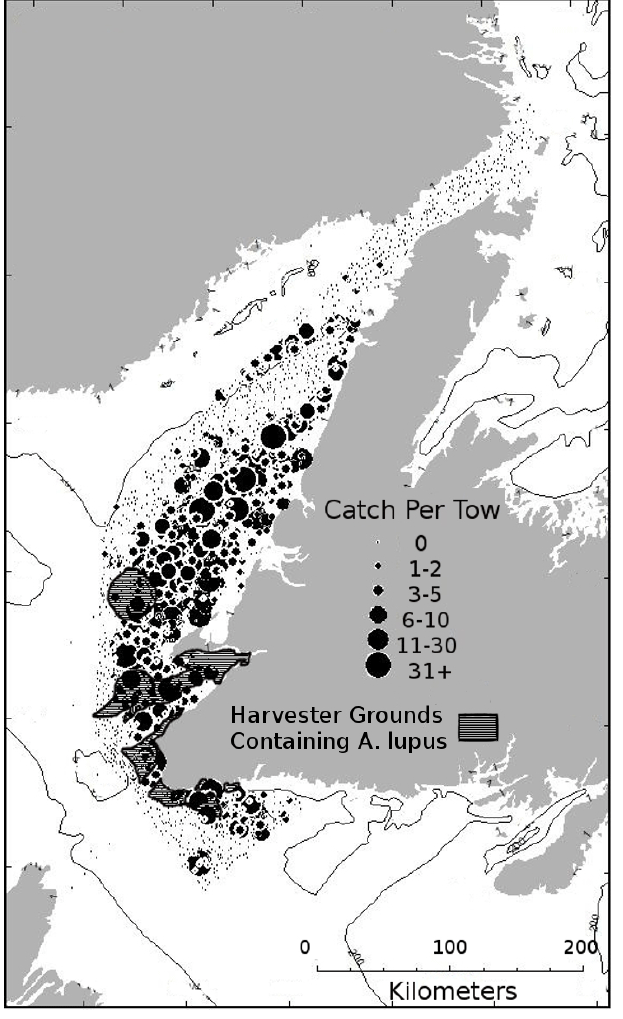
Fig. 3 . A comparison of fishery-independent data (bubble plot) and local ecological knowledge interview data (polygons) for Anarhichas